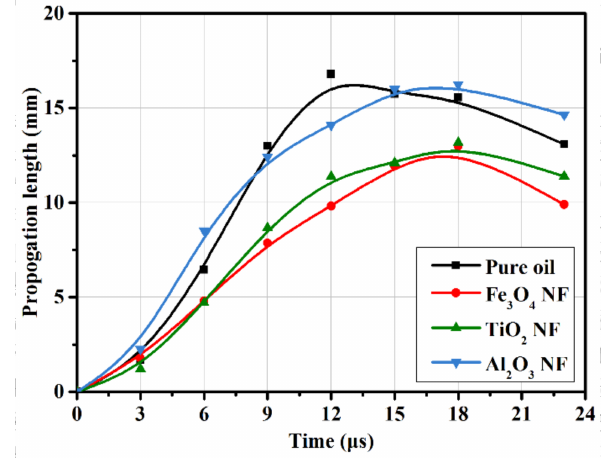
Figure 6. Prebreakdown streamer propagation length in pure oil and nanofluids versus propagation